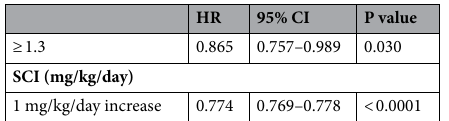
Table 2. Hazard ratios and 95% confidence intervals for variables evaluated as potential predictors of mortality among all patients. CVD cardiovascular disease, nPCR normalized protein catabolic rate, SCI simplified creatinine index.